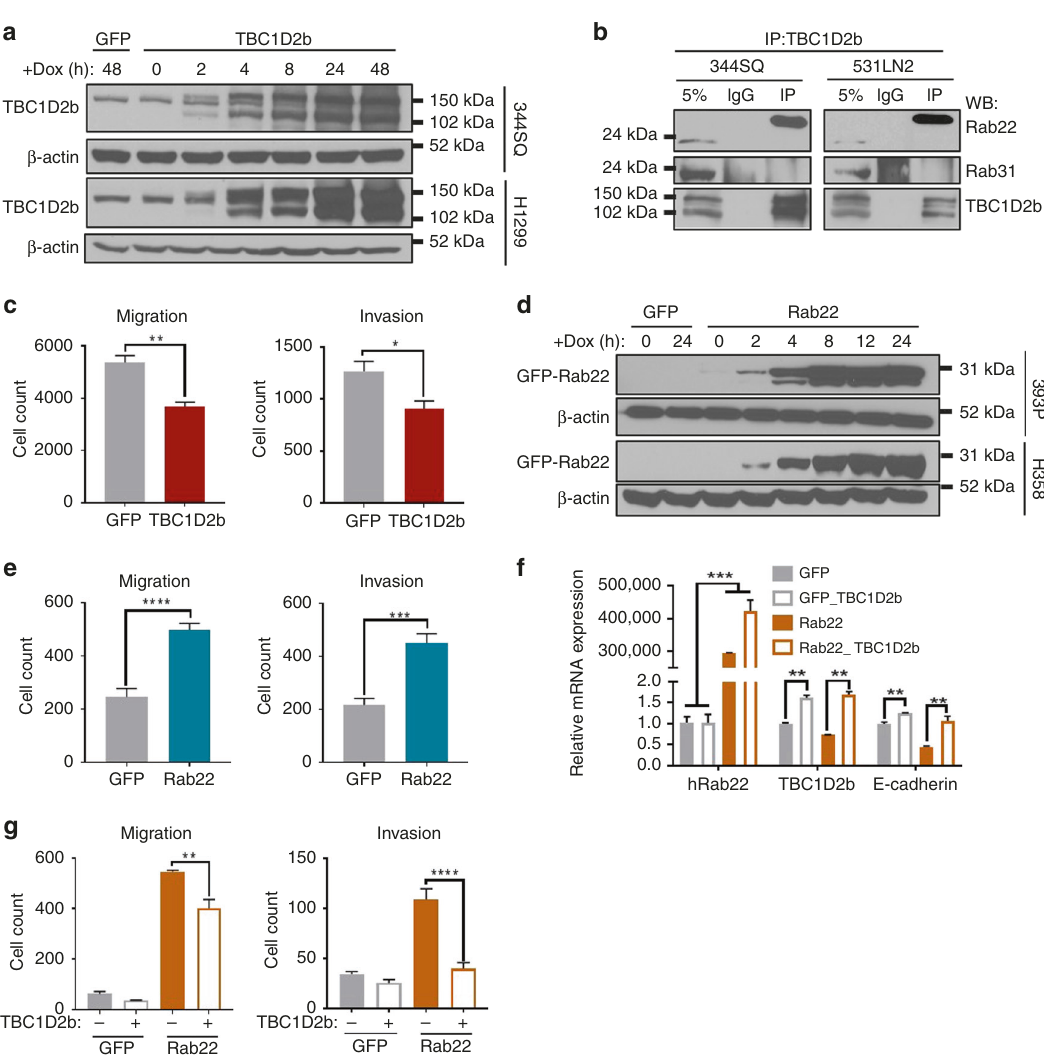
Fig. 5 TBC1D2b hinders Rab22-mediated invasion. a Doxycycline-inducible murine TripZ-TBC1D2b construct was expressed in 344SQ and H1299 cell lines. Western blot demonstrates TBC1D2b expression over 48 h of time course induction. b Co-immunoprecipitation validates TBC1D2b interacts with Rab22 in 344SQ and 531LN2, however, no association was detected with Rab31 in these murine NSCLC cell lines (5% indicates whole cell lysate). c Quanti fi cation of Boyden chamber assay indicates 24 h of TBC1D2b overexpression diminishes cell migratory and invasive potential in 344SQ cell line; all asterisks indicate statistical signi fi cance by t -test ( n ≥ 3, * p ≤ 0.05); error bars represent standard error mean. d Western blot con fi rms overexpression of human GFP-Rab22 in 393 P and H358 cell lines. e 393P_GFP-Rab22 overexpressing cells exhibit increased Boyden chamber migration and invasion; all asterisks indicate statistical signi fi cance by t -test ( n ≥ 3, * p ≤ 0.05); error bars represent standard error mean. f pLenti-TBC1D2b construct was transiently expressed in 393P_GFP or 393P_GFP-Rab22 cell lines for 24 h prior to 24 h of doxycycline induction. mRNA con fi rms overexpression of TBC1D2b (48 h) and Rab22 overexpression (24 h). g In vitro transwell migration and invasion assay following TBC1D2b overexpression in 393P_GFP and 393P_GFP-Rab22 cell lines